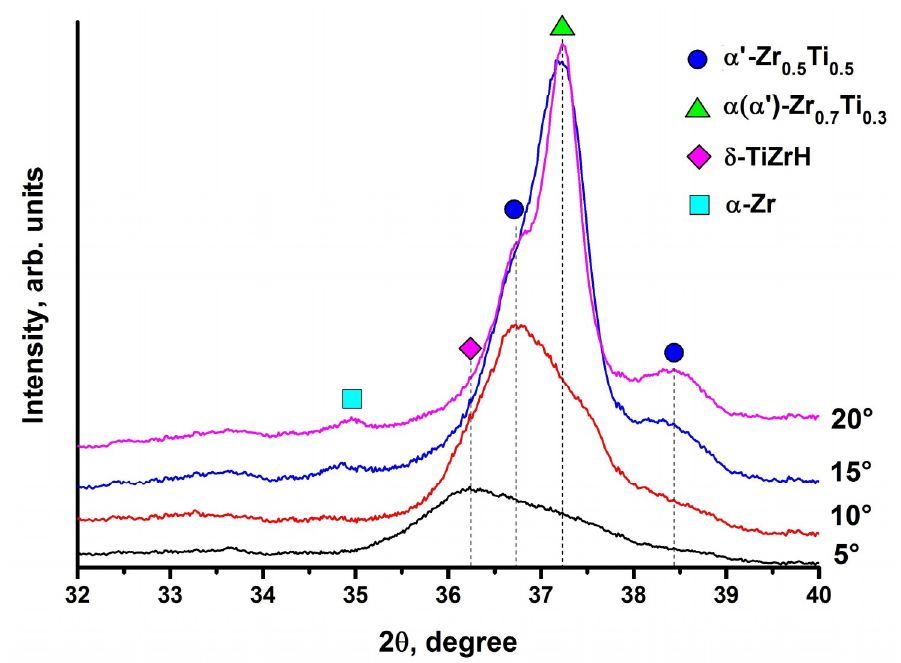
Figure 6. Grazing incidence X-ray diffraction (GIXRD) patterns of the hydrogenated Ti-implanted alloy. Table 3. Phase composition and lattice parameters of the phases in hydrogenated samples.